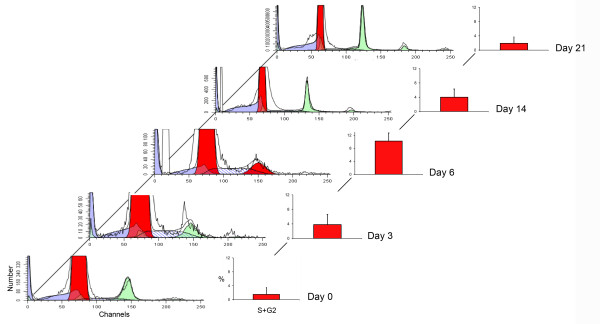
Cell cycle profiling of post-pneumonectomy lung CD31+ endothelial cells obtained by enzymatic digestion and analyzed using flow cytometry (ModFit, Verity Software House). Automated analysis of the ModFit model components, processed by a Marquardt nonlinear least-squares analysis, excluded aggregates (green) and identified S phase (blue hatched area) and G2 phase (second red peak) cells at five time points (Day 0, 3, 6, 14 and 21). The combined analysis of the percentage of cells in S+G2 phase of the cell cycle at various time points after pneumonectomy in the column chart (right; mean ± SD; 4-6 mice per time point).